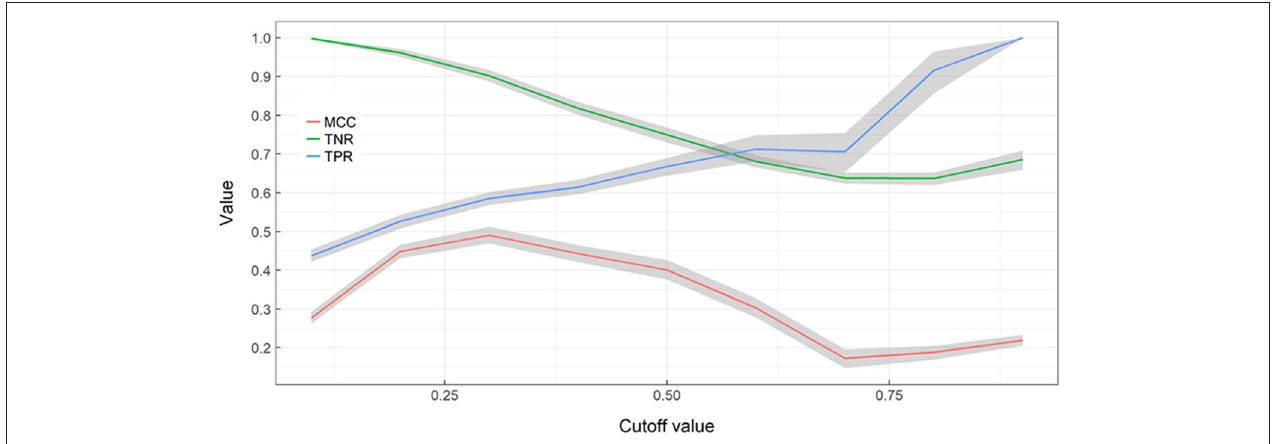
FIGURE 4 | Performance of Random Forest ensemble vs. training cut-off value. A nonparametric bootstrap is used to obtaining confidence limits (gray areas) and bootstrap means for the Matthews correlation coefficient (MCC), True Negative Rate (TNR), True Positive Rate (TPR), without assuming normality.